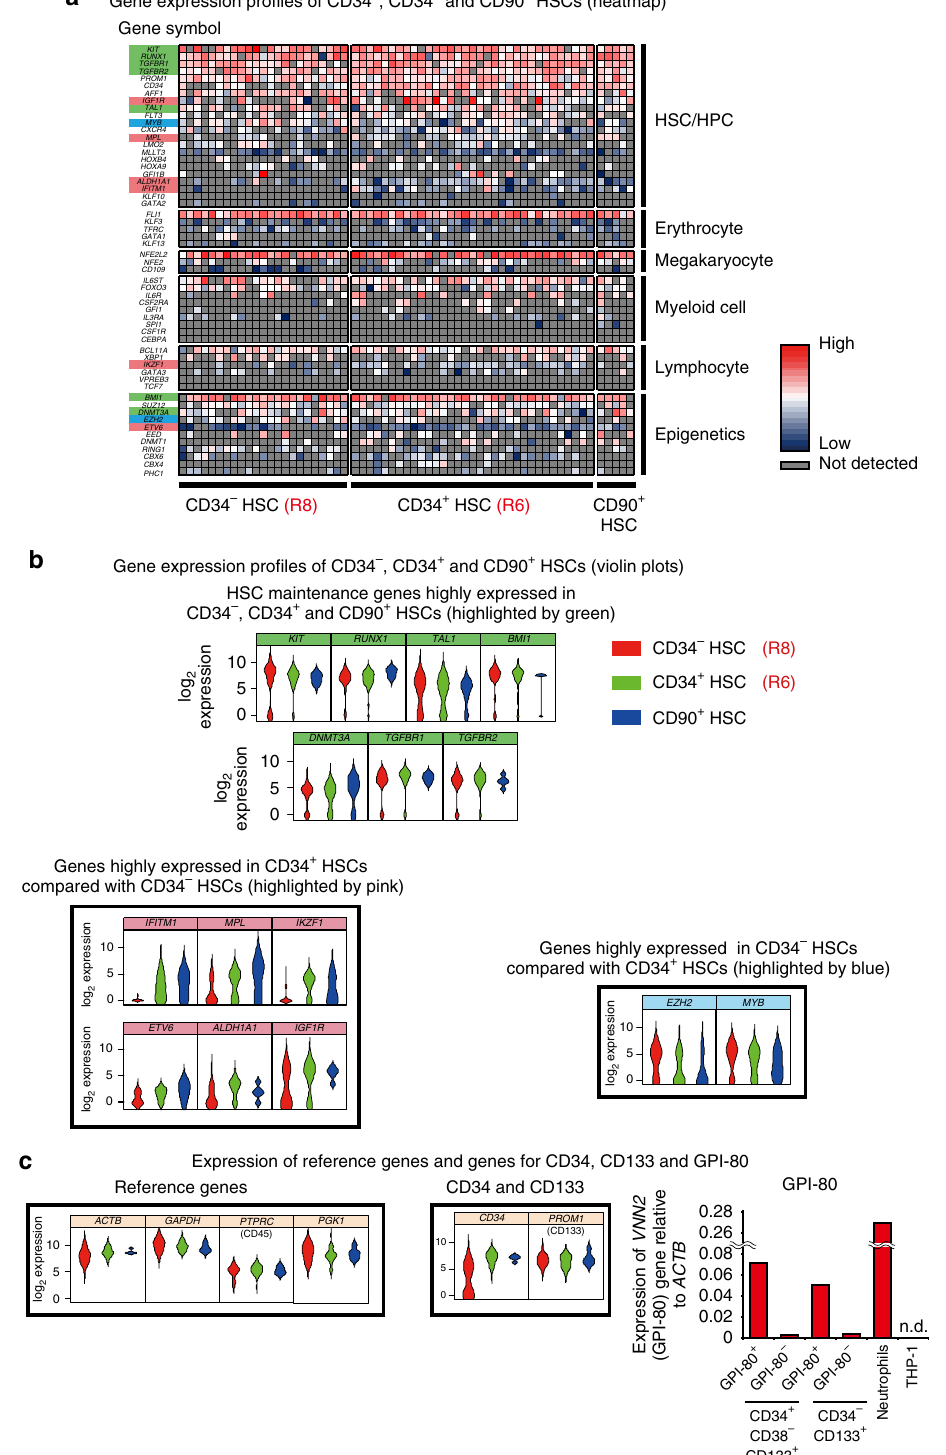
Next, we compared the gene expression pro fi les of CD34 + and Fig. 11, CD34 + and CD34 − HSCs expressed comparable levels of IFNAR1 and R2 receptors, TYK2 and JAK1 . However, CD34 − CD34 − SRCs (HSCs) with those of non-SRCs (non-HSCs) by a HSCs expressed signi fi cantly lower levels of their downstream GSEA. The results showed that gene sets related to quiescence, target genes, including STAT1 , IFITM1 , IFITM3 , DDX58 , IFI44 , in fl ammatory signaling, HSC markers, cell adhesion, cytokine + CXCL10 and CXCL11 than CD34 signaling and chemokine/migration were enriched in CD34 HSCs. As recently reported, high levels of IFN- α activated dormant HSCs in vivo 37,38 . These CD34 − SRCs (HSCs) (Supplementary Fig. 12a right). In contrast, − HSCs may be more resistant results therefore suggest that CD34 gene sets related to cell cycle progression, differentiation, DNA than CD34 + HSCs to chronic activation of the IFN- α pathway. replication, metabolism and organellar activity were enriched in